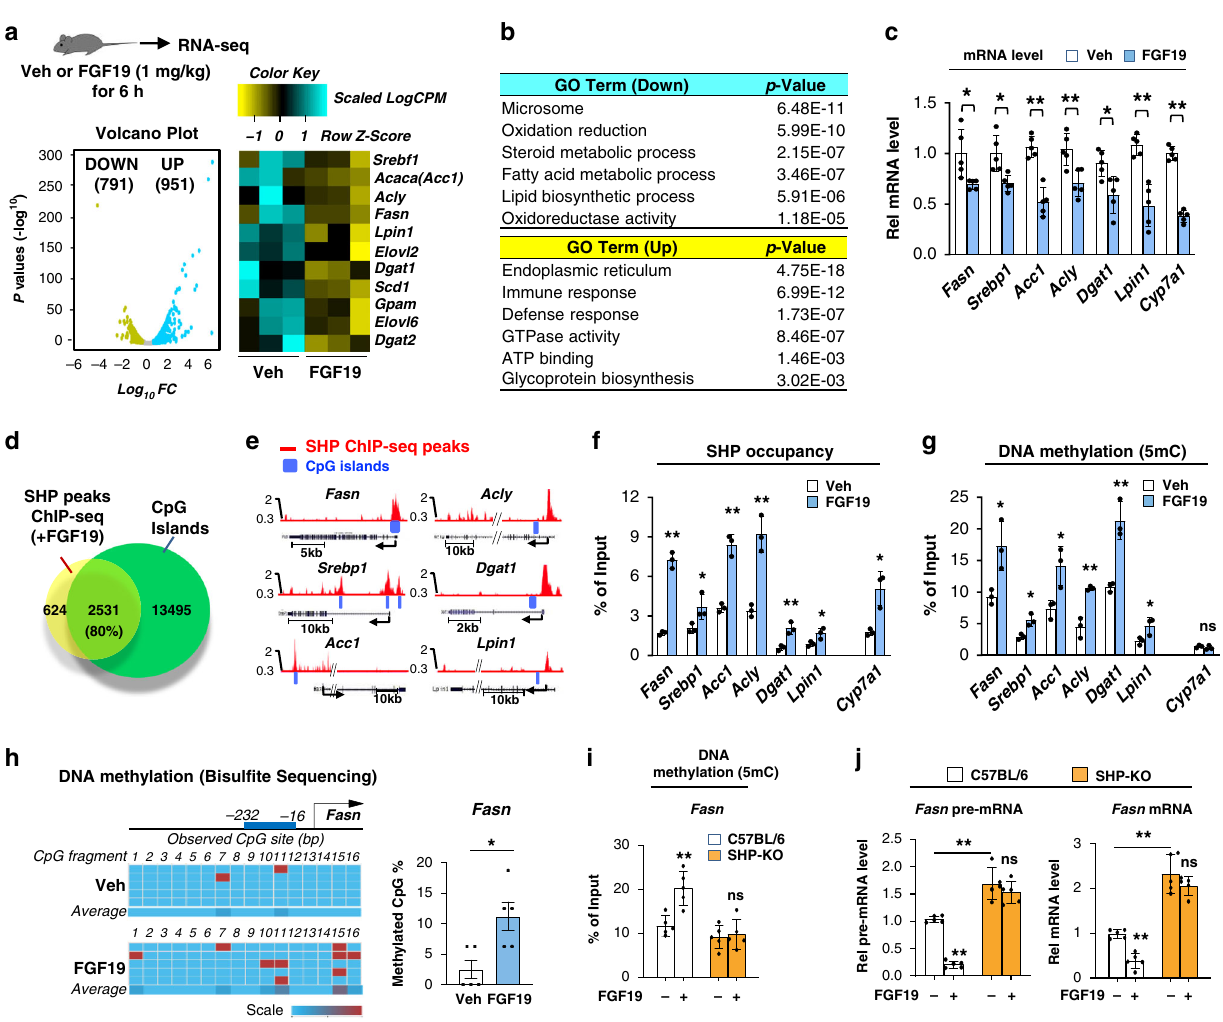
Fig. 2 SHP occupancy and DNA methylation are increased at lipogenic genes after FGF19 treatment. a – c C57BL/6 mice were treated with vehicle or FGF19 for 6 h after fasting overnight. a , b Total RNA was isolated from mouse liver and analyzed by RNA-seq. a A volcano plot showing genome-wide changes in mRNA level (left) and a heatmap of the differential expression of lipogenic genes in mice treated with vehicle or FGF19 (right). b Selected biological pathways increased or decreased by FGF19 treatment as determined by gene ontology (GO) analysis. c Relative mRNA levels of selected lipogenic genes measured by RT-qPCR. d Venn diagrams showing the numbers of SHP binding peaks increased by FGF19 treatment of mice for 2 h in hepatic chromatin using published ChIP-seq data 18 and the numbers of CpG islands. e Normalized SHP binding peaks (Red) and CpG islands (Blue) at selected lipogenic genes displayed using the UCSC genome browser. f , g C57BL/6 mice were treated with vehicle or FGF19 for 2 h. f SHP occupancy or g DNA methylation at promoters of the indicated lipogenic genes determined by ChIP or MeDIP, respectively. h DNA methylation at speci fi c sites of Fasn promoter determined by bisul fi te sequencing. i , j C57BL/6 and SHP-KO mice were treated with vehicle or FGF19 for 2 h ( i , j -left) or 6 h ( j -right). i DNA methylation determined by MeDIP at hepatic Fasn and j hepatic pre-mRNA and mRNA levels. c , f - j The mean and standard deviation are plotted ( n = 5). Data presented as mean values ± SD are shown ( c , h - j , n = 5 mice; f , g , n = 3 mice), and statistical signi fi cance was determined by ( c , f – h ) two-tailed Student ’ s t -test or ( i , j ) two-way ANOVA with the Tukey post-test. * P < 0.05, ** P < 0.01, ns, statistically not signi fi cant. In b , exact p-values are produced by DAVID v6.8 program (https://david.ncifcrf.gov/) which are computed by summing probabilities p over de fi ned sets of tables (Prob = ∑